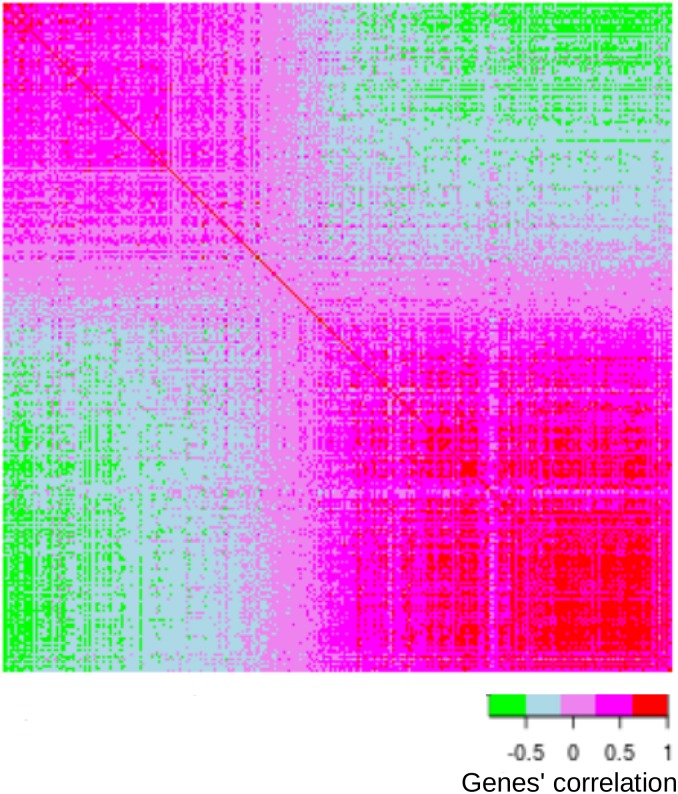
Heatmap representing the correlations between the 938 genes used in DiCA.The correlation coefficients between genes were computed using all 394 regions. The genes are ordered according to their positions on the dimension extracted by DiCA. Red to magenta colors denote strong positive correlations whereas green denotes a strong negative correlation. The genes are clearly organized into two blocks that are related to the gene differential expression for the two rings.